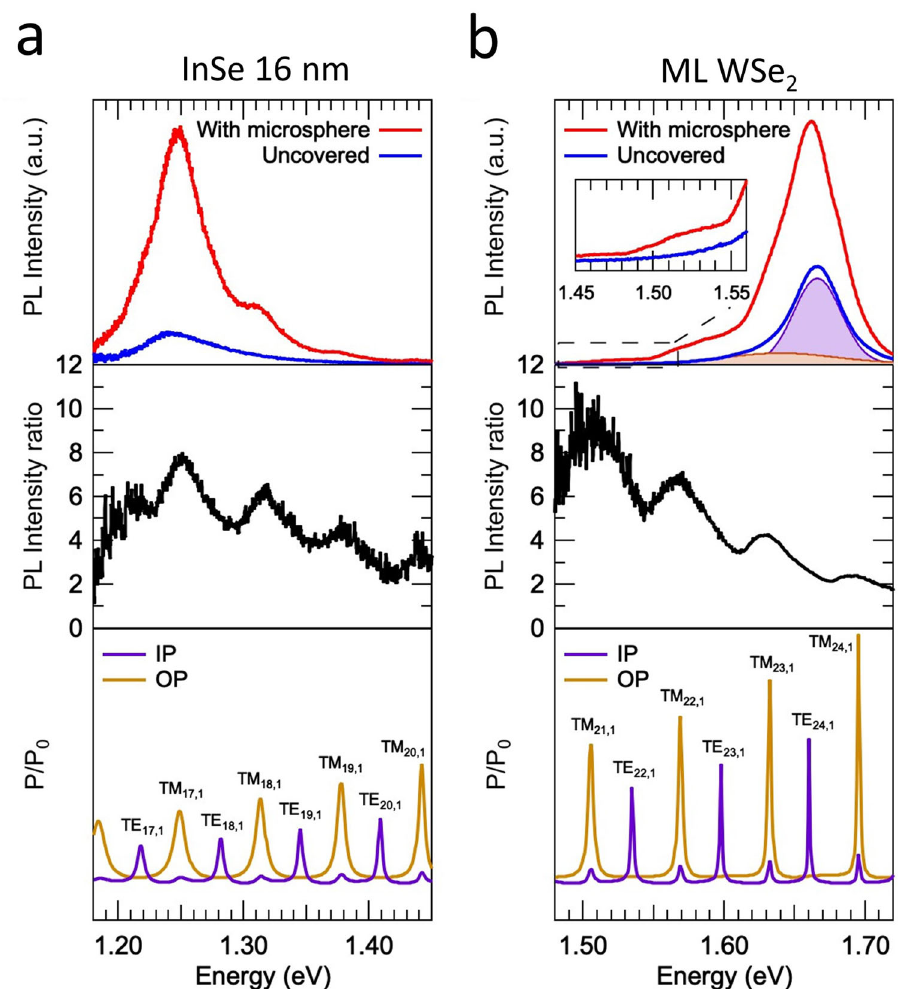
Fig. 3 Revealing the OP orientation of dipoles by the excitation of WGMs of dielectric microspheres. Top panels: μ -PL spectra acquired in the a 16-nm- thick InSe nanosheet and b monolayer WSe 2 which have been already shown in Fig. 1b, c, respectively. Middle panels: intensity ratio between the PL spectra shown in their respective top plots, which evidence the coupling of emitted light to the WGMs of dielectric microspheres. Bottom panels: spectral response calculated for a dipolar emission coupled to the WGMs of a spherical microresonator of 4.69 μ m in diameter, when these emitting dipoles are IP (purple curve) or OP (orange curve) oriented. The TM or TE character of each WGMs has been indicated on each resonance